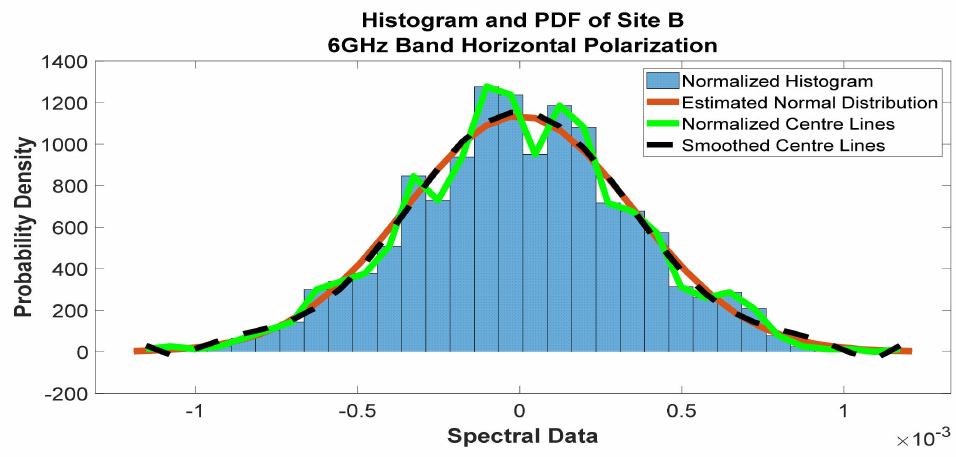
Figure 12. Histogram and PDF of the frequency scan for site B at 6 GHz horizontal polarization.